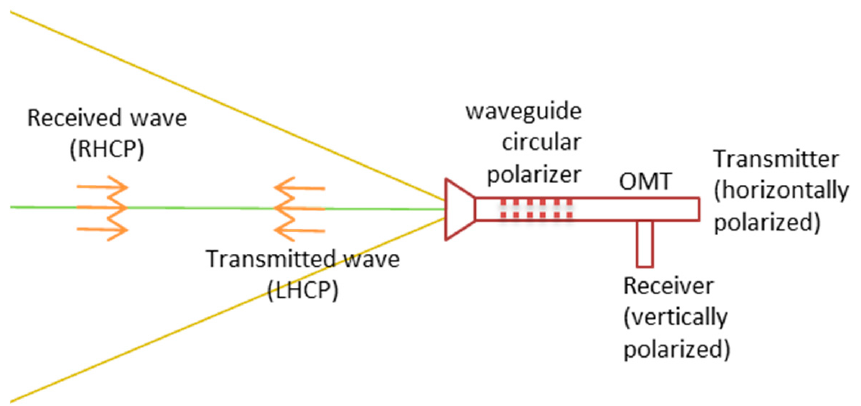
Figure 8. Feed systems using orthomode transducers (OMTs) instead of linear polarization (LP) filters for producing both vertical and horizontal polarizations from an antenna.